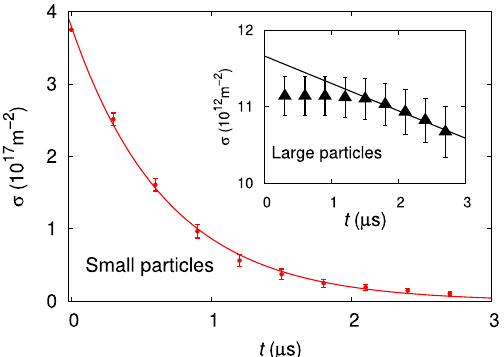
Figure 7. The simulated growth island densities with standard errors as a function of time for small and large particles as in the case of µ -YBCO and n-YBCO, respectively. The solid lines are fits to the exponential (small particles) and linear (large particles) functions.